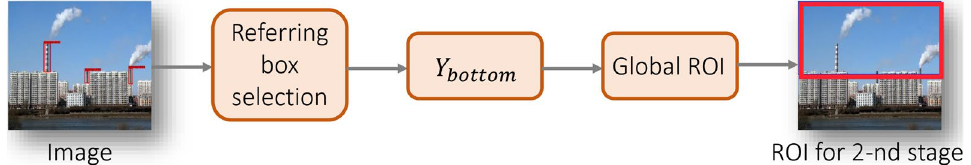
Figure 4. The function diagram of multi-object relation-guided module. For three prediction boxes from the first stage, this module selects Y bottom of the biggest Y value at the top left vertex and finds the corresponding box. In combination with the global ROI, it further determines the detected ROI region in the second stage. Please refer to “”Relation-guided module” for the process of the detailed